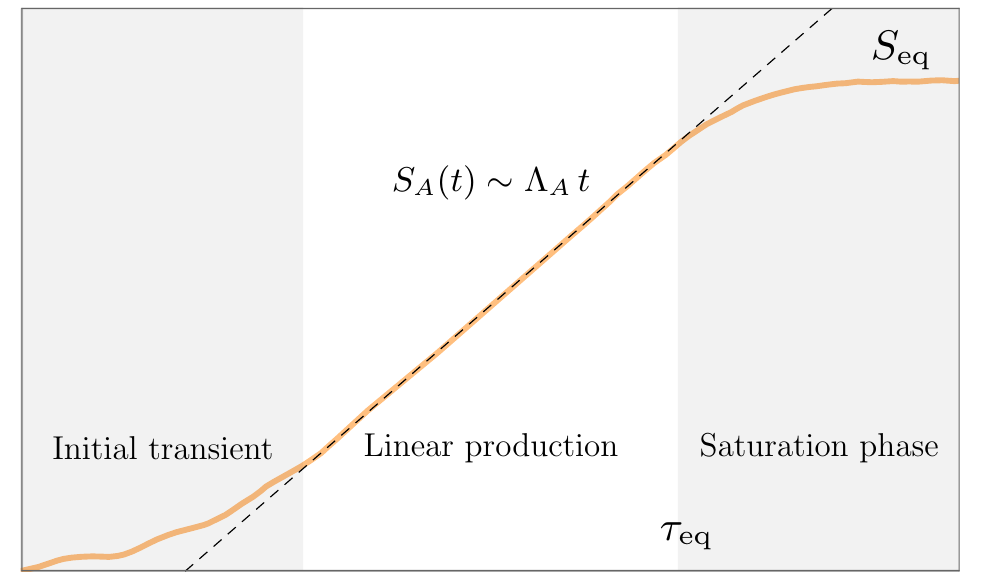
Figure 1 . Sketch of typical entanglement production . Typical time dependence of the entanglement entropy S A ( t ) under unitary time evolution: after an initial transient (a), linear production occurs with characteristic rate (cid:3) A (b), and (cid:12)nally the system equilibrates in the saturation phase (c). The typical time scale for the equilibration of a state with initially vanishing entanglement entropy is (cid:28) eq (cid:24) S eq = (cid:3) A